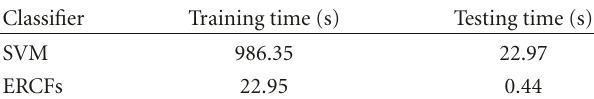
Table 6: Time comsuming of SVM and